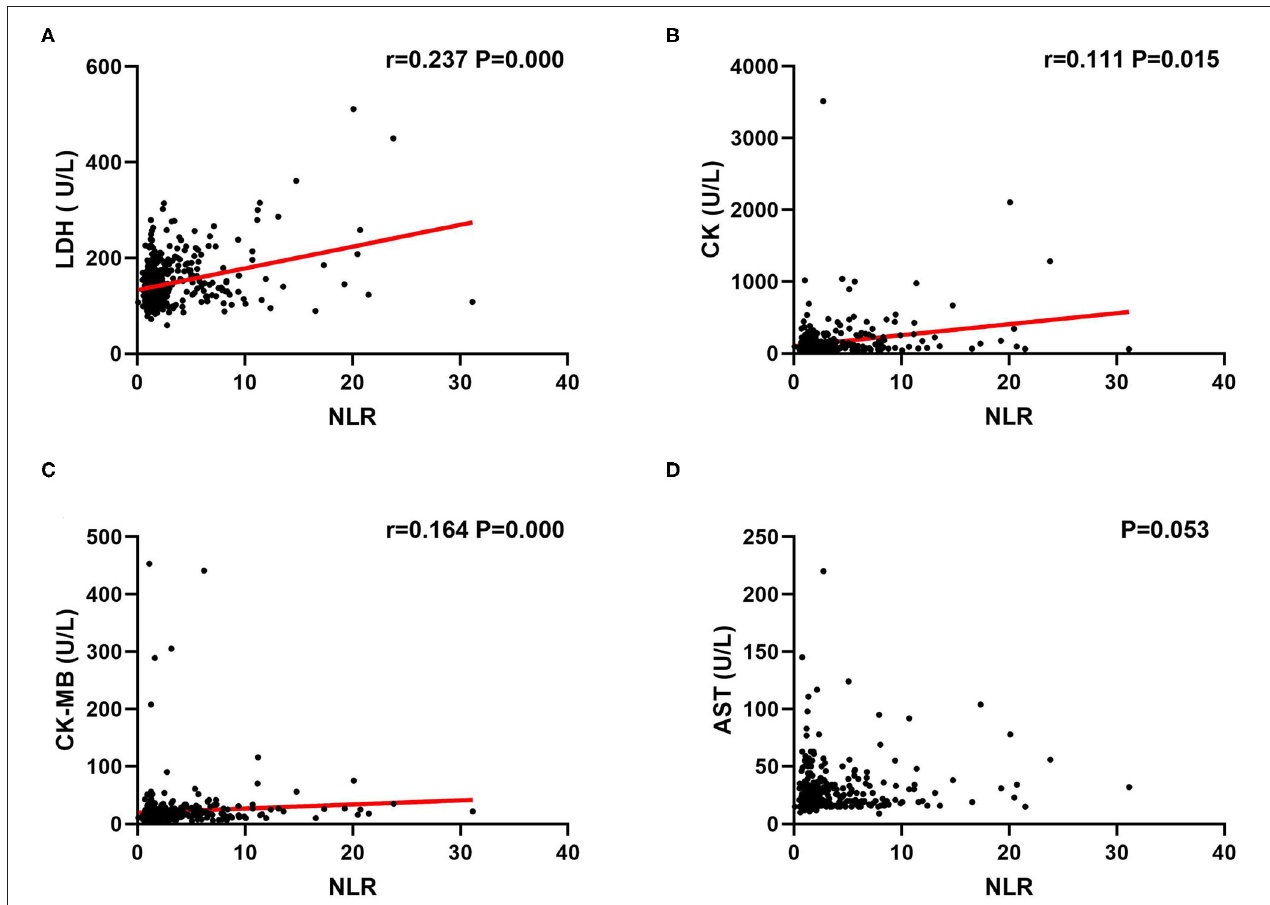
FIGURE 1 | Correlation between NLR and myocardial enzymes at high altitude by Spearman correlation analysis. NLR had a significant positive relationship with LDH (A) , CK (B) and CK-MB (C) instead of AST (D) . Correlation coefficient (r) and P values are shown. NLR, neutrophil to lymphocyte ratio; LDH, lactate dehydrogenase; CK, creatine kinase; CK-MB, creatine kinase isoenzymes; AST, aspartate amino